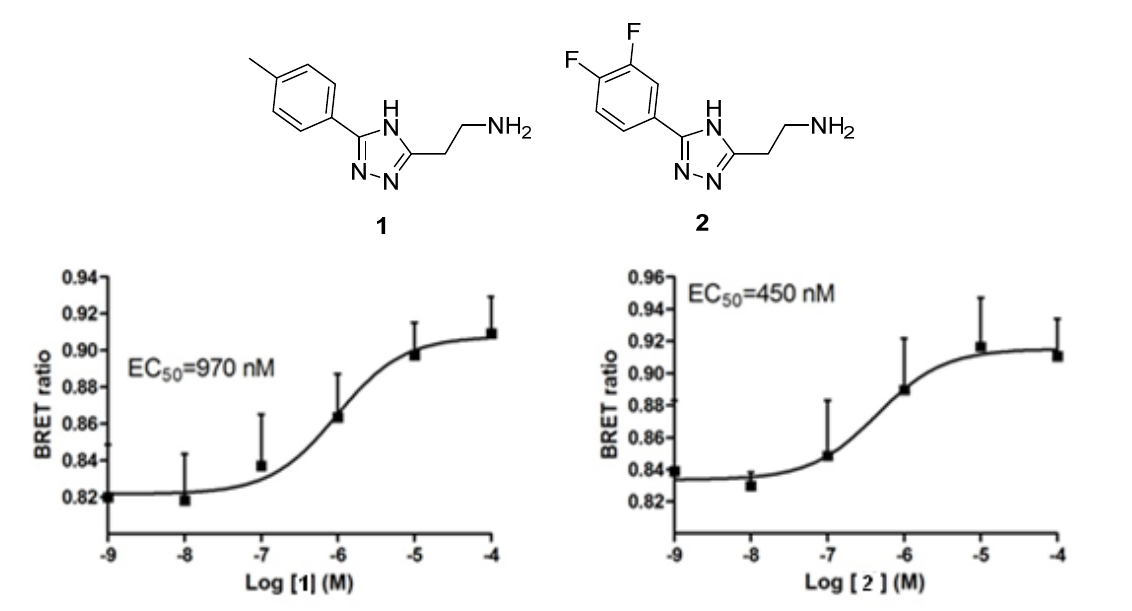
Figure 2. Structures and TAAR1 activation dose–response curves of screening hits 1 and 2 (n = 3). In order to improve the potency of the newly identified chemotype and possibly un ‐ derstand structure–activity relationships, we performed a massive hit ‐ to ‐ lead analog syn ‐ thesis by utilizing diversely substituted stock ‐ available (hetero)aromatic carboxylic acid hydrazides 3 and Boc ‐ protected amino amidine building block 4 [28], as depicted in Scheme 1. The three steps were conducted with only one intermittent chromatographic purification after the neat melting of N ‐ acyl amidrazone 5 . Thus, the yields of hydrochlo ‐ rides 6 – 57 were calculated over the three consecutive steps.